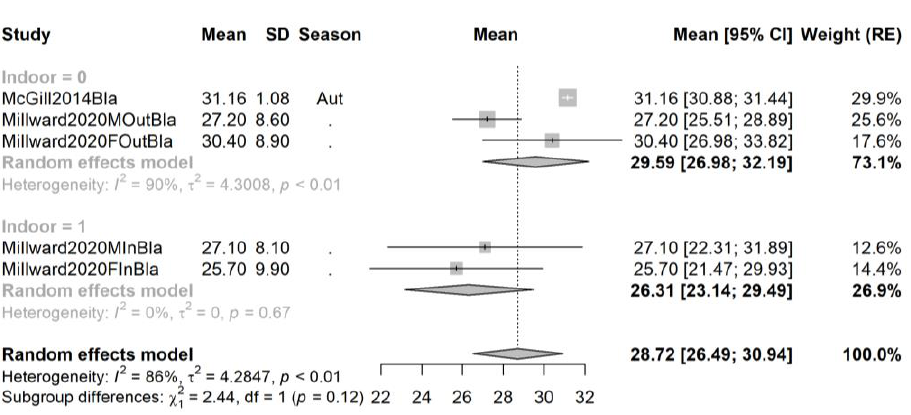
Figure 4. Forest plot of all studies performed on African-American athletes sorted by season. Stud- ies [51,68].